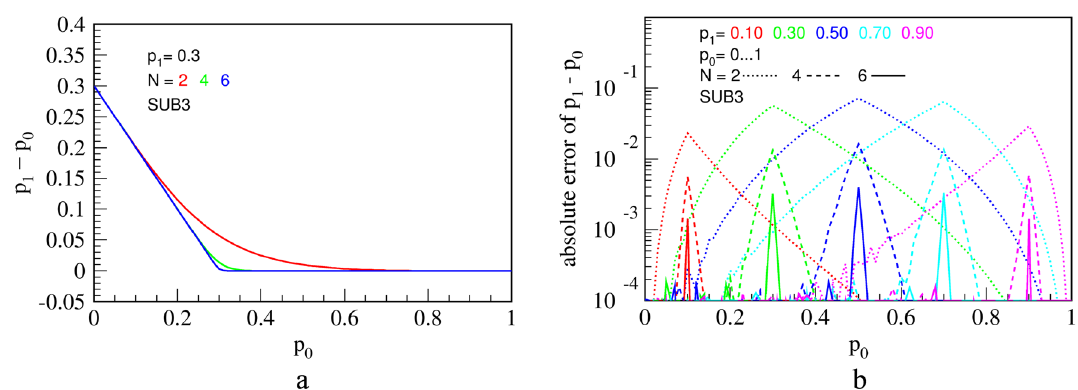
Figure 21. Measured transfer function (a) ; and errors (difference from the ideal division) (b) for the circuit SUB3, for a fixed value of p 1 = 0.3 and counter capacities of N = 2, 4 and 6 bits.